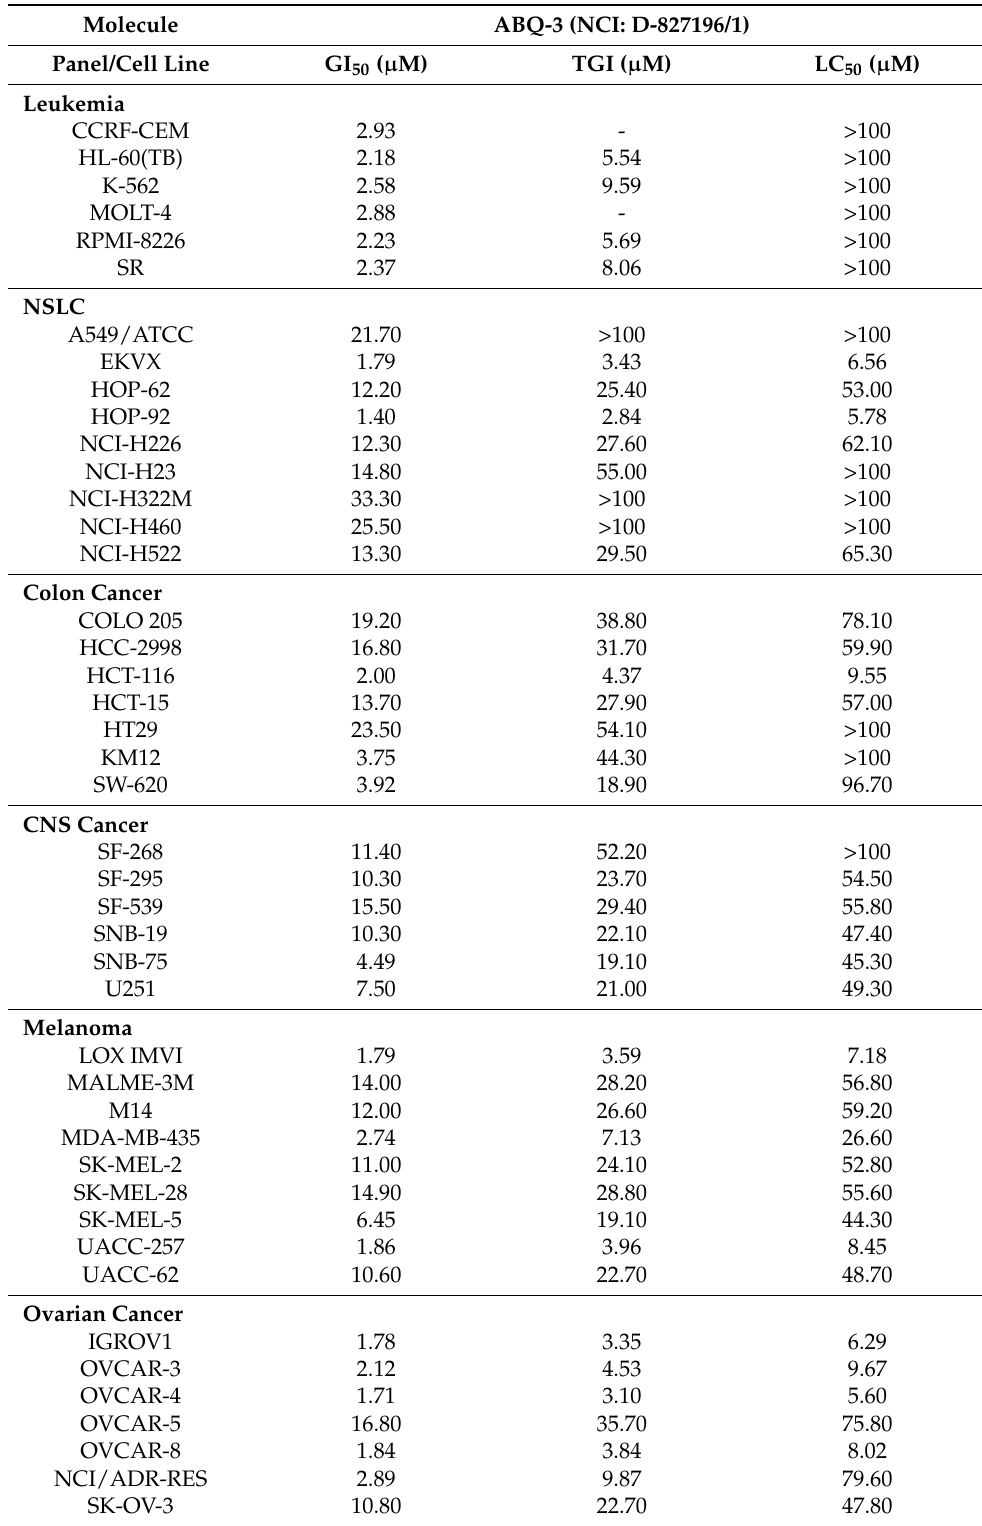
Table 2. The GI 50 , TGI, and LC 50 values of ABQ-3